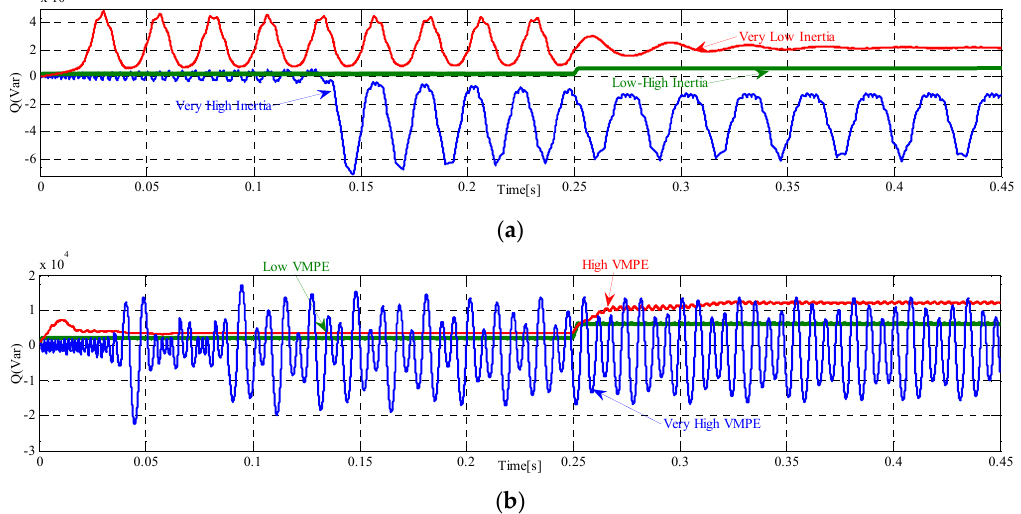
Figure 10. Reactive power of the proposed controller-based converter under: ( a ) various inertia values, and ( b ) various VMPE values.